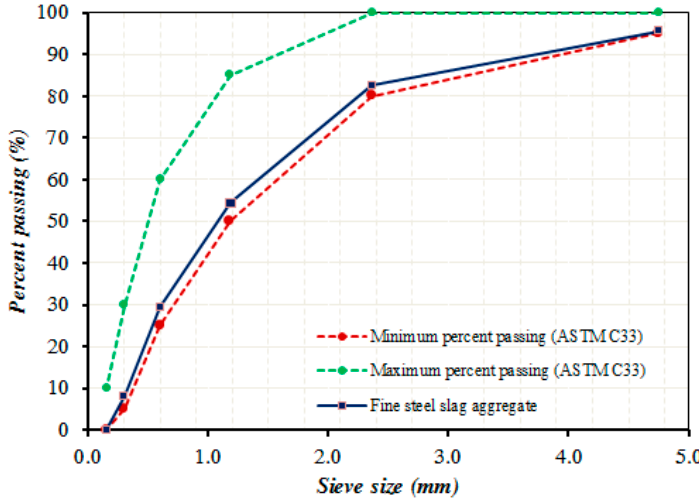
Figure 2. Gradation curves of fine aggregate.